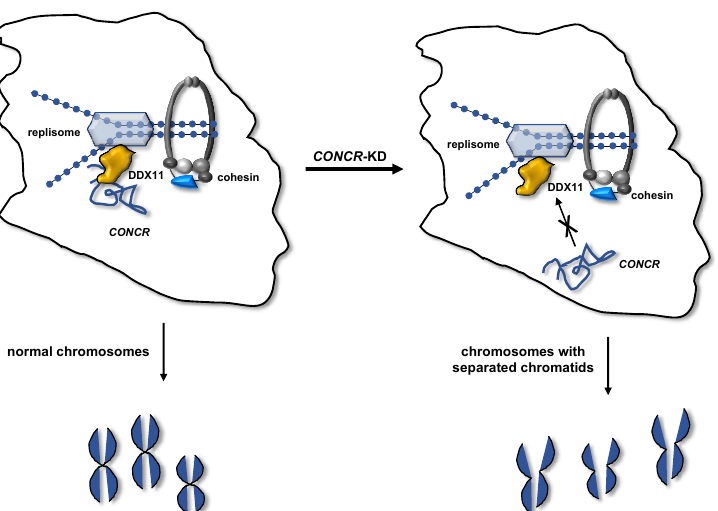
Figure 2. Regulation of sister chromatid cohesion by the lncRNA CONCR . CONCR transcription is directly activated by Myc in a p53-deficient background. CONCR enhances the DDX11 catalytic activity, promoting sister chromatid cohesion establishment at the replication forks. CONCR knockdown causes sister chromatid cohesion loss.